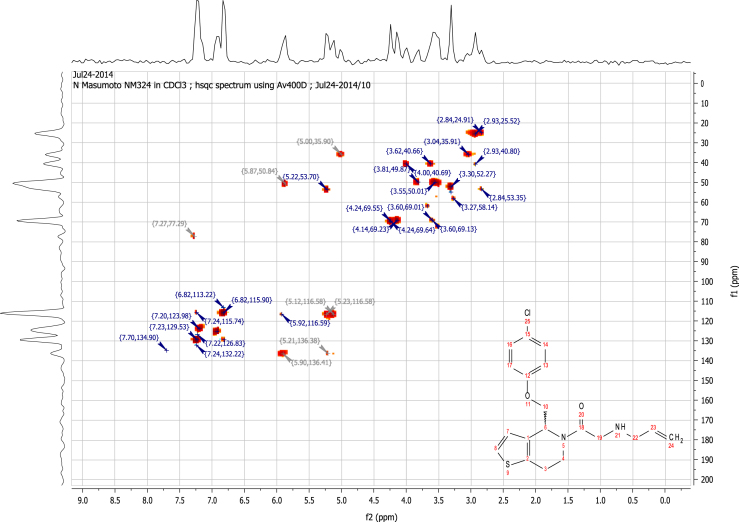
2D HSQC (400 MHz,
CDCl3) of RU-SKI 41
(9a).